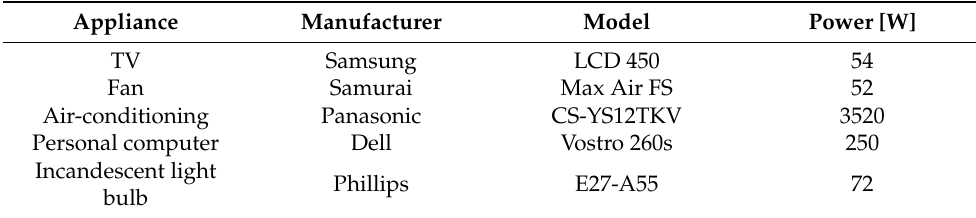
Table 9. Characteristics of the electrical appliances of the test